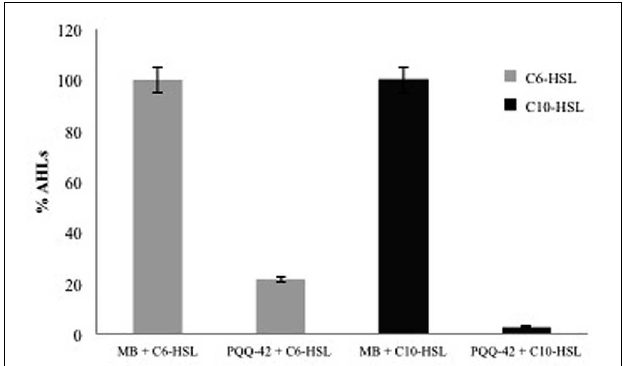
FIGURE 1 | High-performance liquid chromatography plus mass-spectrometry analysis (HPLC-MS) measurements of C 6 -HSL and C 10 -HSL in the cell-free culture media of the N -acylhomoserine lactones (AHL)-degrading strain PQQ-42 after 24 h. Cell-free MB medium was used as negative control. Initial AHL concentration was 10 µ M. Error bars represent one standard deviation.